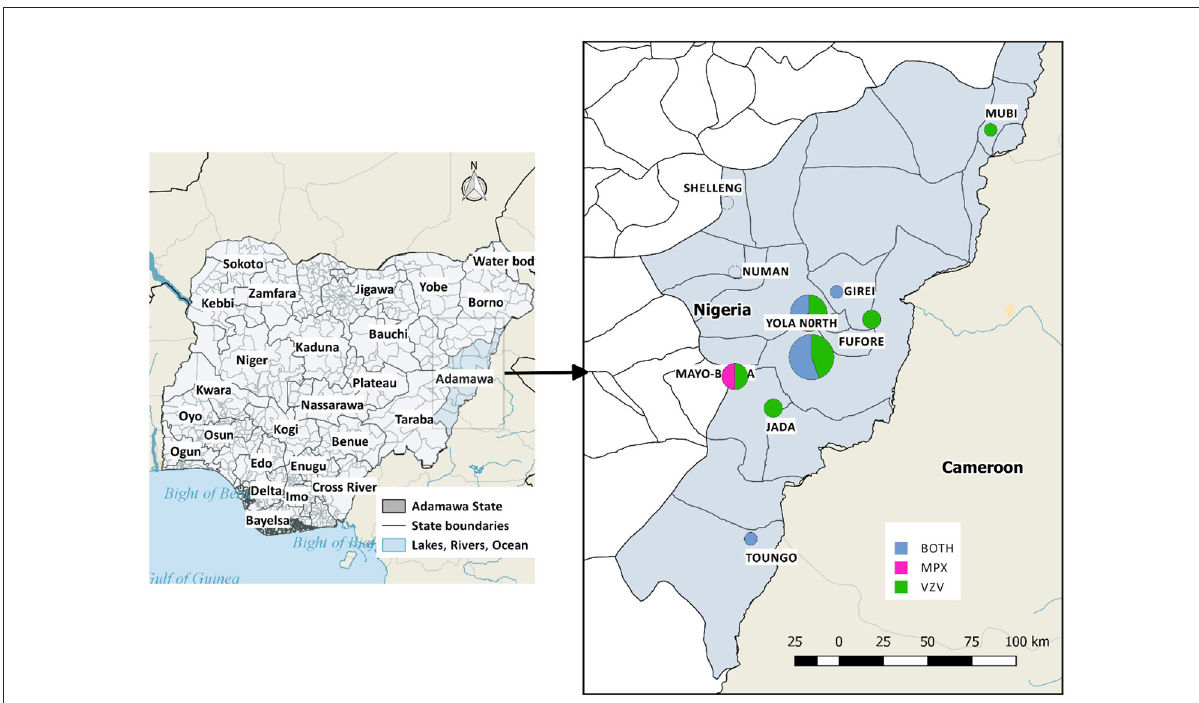
FIGURE1 Map of the study area, with the affected local government areas of Adamawa State. Positive cases of MPX and/or VZ were reported in Mubi (1), Girei (1), Yola North (8), Yola South (12), Fufore (2), Mayo-Belwa (4), Jada (2), Toungo (1). Shelleng and Numan have suspected cases but tested